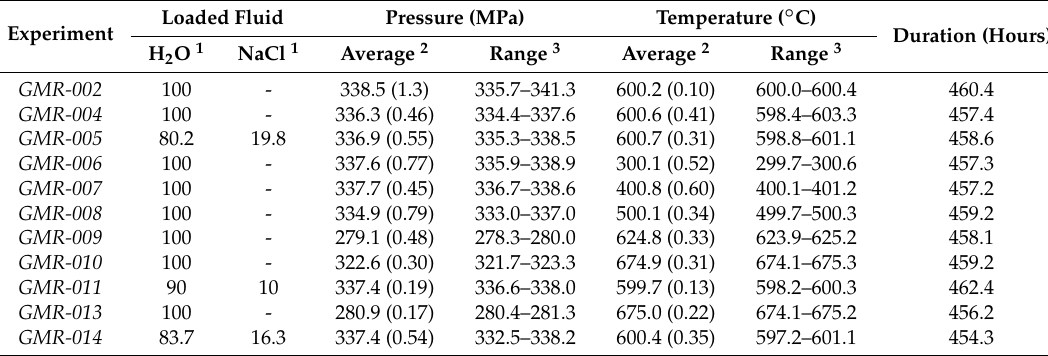
Table 1. Conditions of the fluid inclusion synthesis experiments.